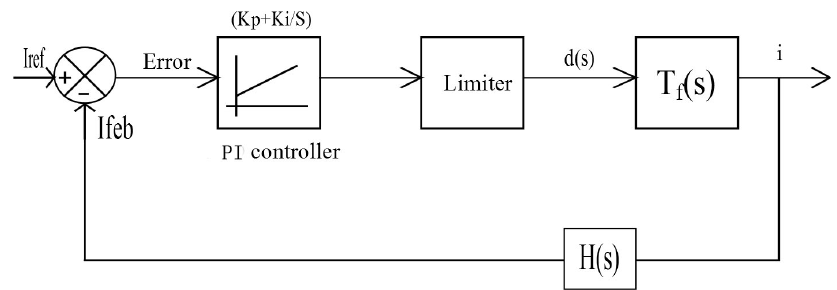
Figure 6. PI current control loop schematic diagram.